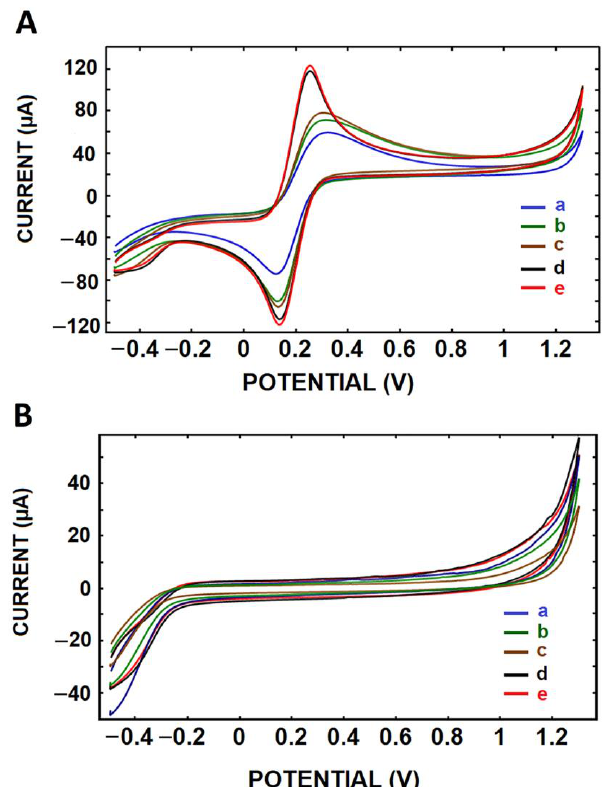
Figure 2. Voltammograms obtained from CV measurements ( A ) in redox prob solution (2 mM Fe(CN 6 ) 3/ − 4 ) with (a) PGE, (b) PGE (control), (c) CNF/PGE, (d) IL/PGE, (e) CNF-IL/PGE ( B ) in 0.01 M KCL solution (a) PGE, (b) PGE (control), (c) CNF/PGE, (d) IL/PGE, (e) CNF-IL/PGE ( n = 3).